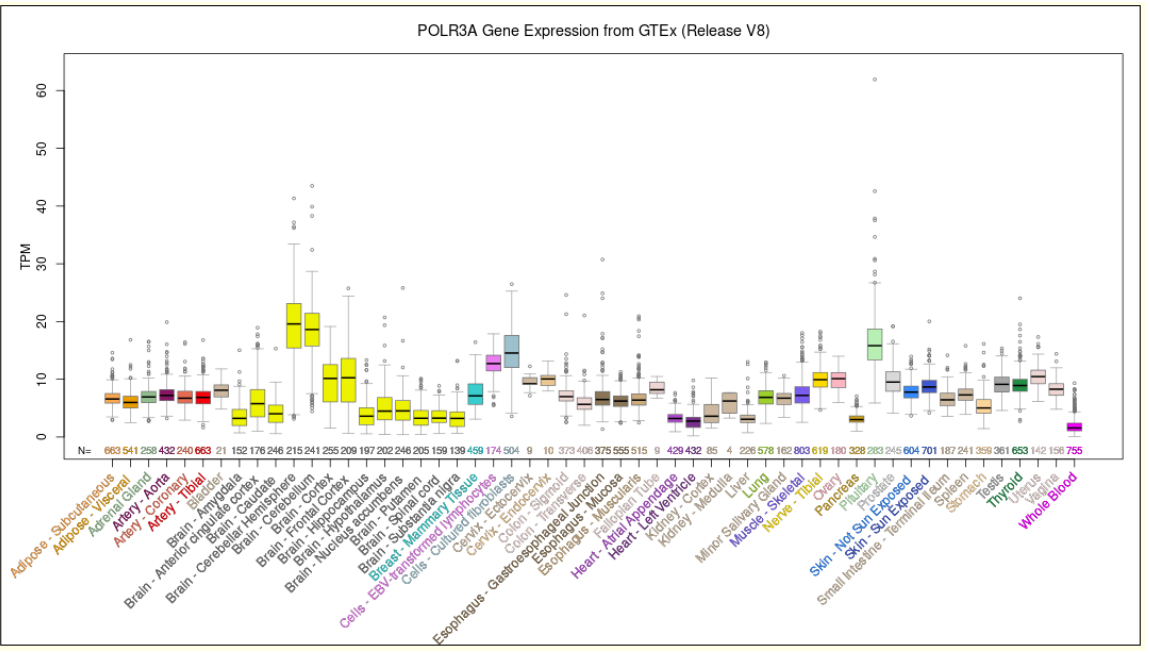
Figure 1. Expression levels of the POLR3A gene in human healthy tissues. The expression level was obtained in 54 human tissues from GTEx RNA-seq of 17,382 samples from 948 donors (V8, August 2019). TPM: transcripts per million. Data and image from the UCSC Genome Browser (http://genome.ucsc.edu, accessed on 23 August 2022).